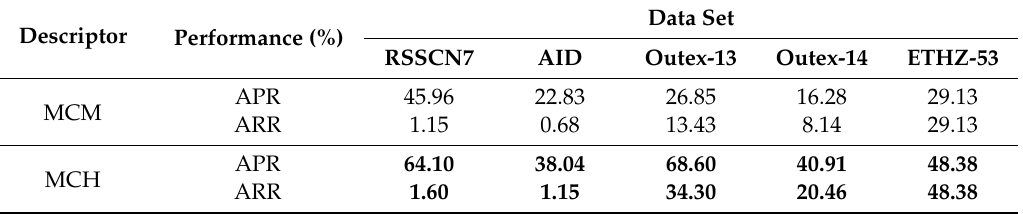
Average precision rate (APR) and average recall rate (ARR) of different motif co-occurrence histograms.